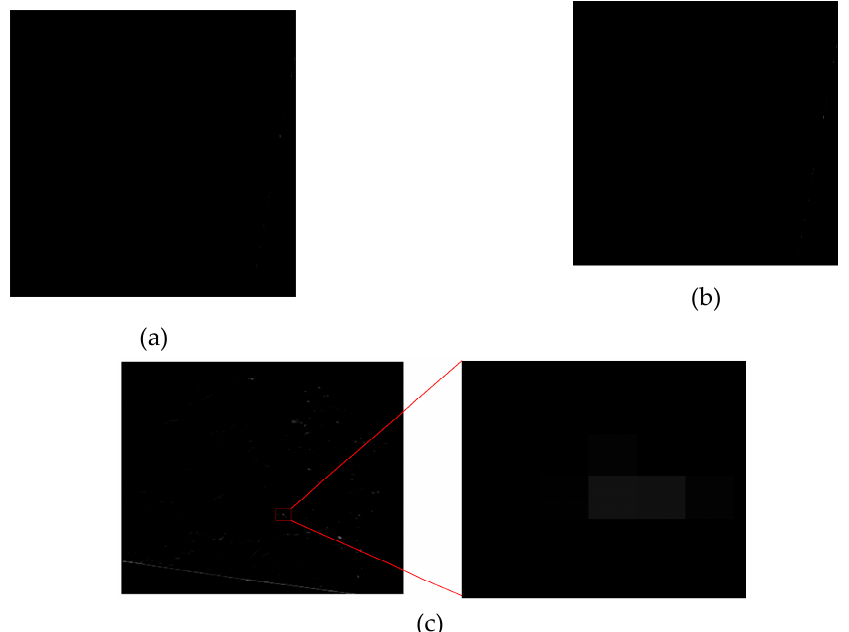
Figure 24. The differences between referencing image and other georeferenced images of the first image. ( a ) The differences between Ref-Img and Img-C++. ( b ) The differences between Ref-Img and Img-MATLAB. ( c ) The differences between Ref-Img and Img-ENVI.